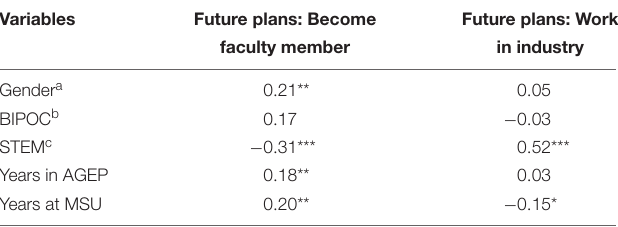
TABLE 9 | Correlations between demographics and future plans